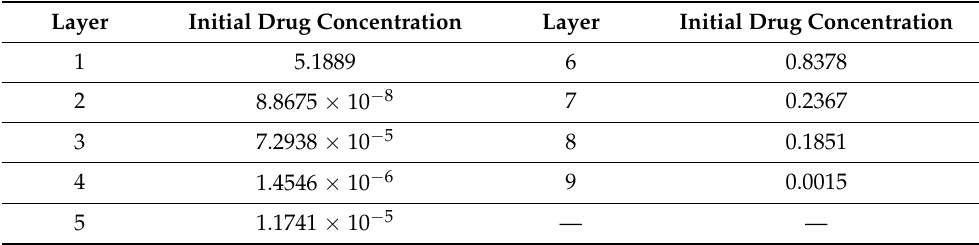
Table 2. Initial drug concentration at each layer of the drug-controlled release system with NL = 9 (Case 1).